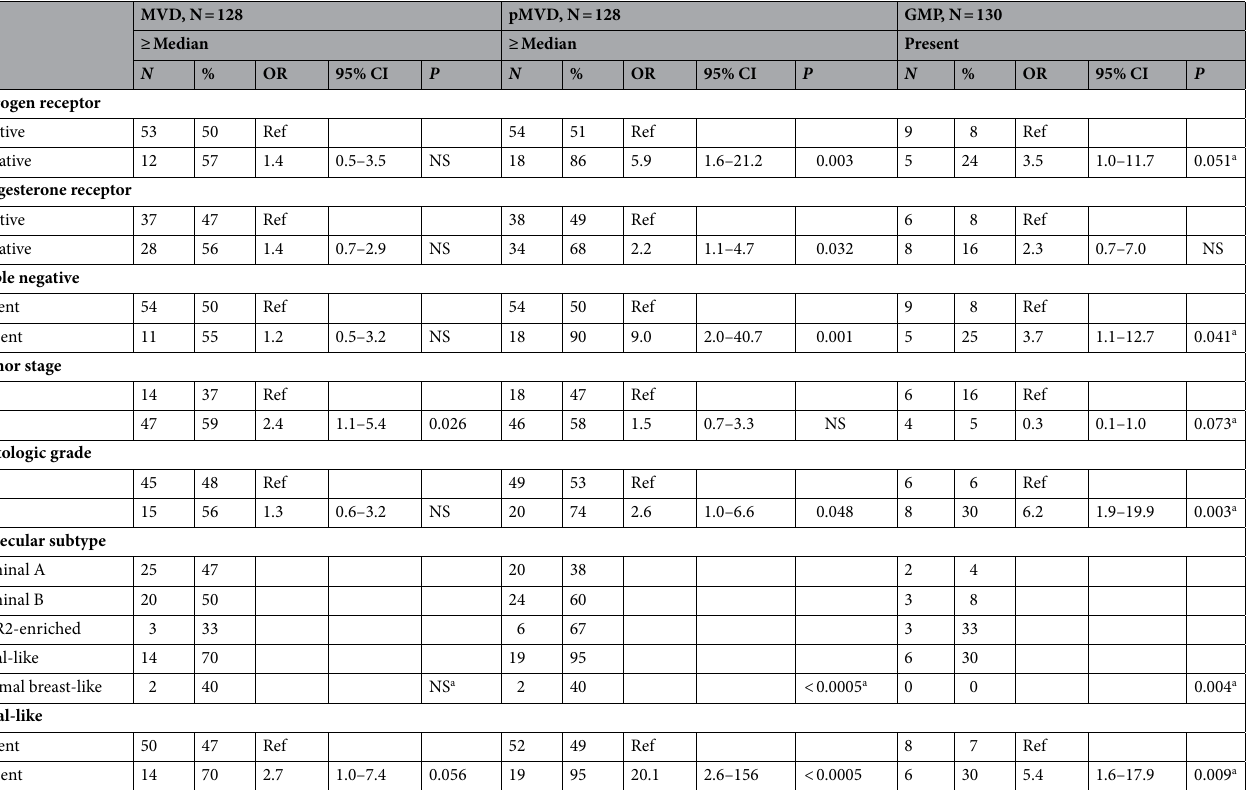
Table 2. MVD, pMVD, GMP by clinico-pathologic variables and molecular subtypes of breast cancer. Tumor stage: T4 tumors were excluded from the analyses. T2: 2,5- < 5 cm and T3: ≥ 5 cm in diameter. MVD